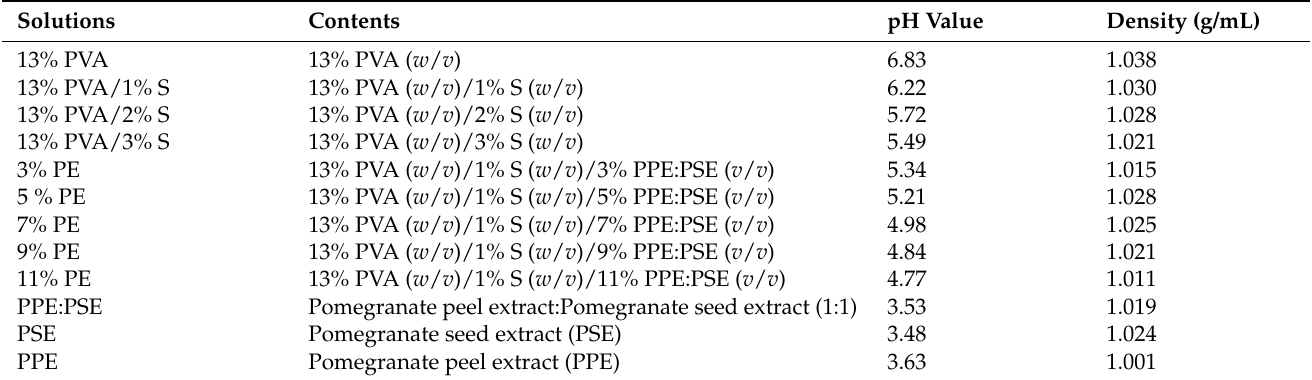
Table 1. Physical properties of each solution and pomegranate extracts.